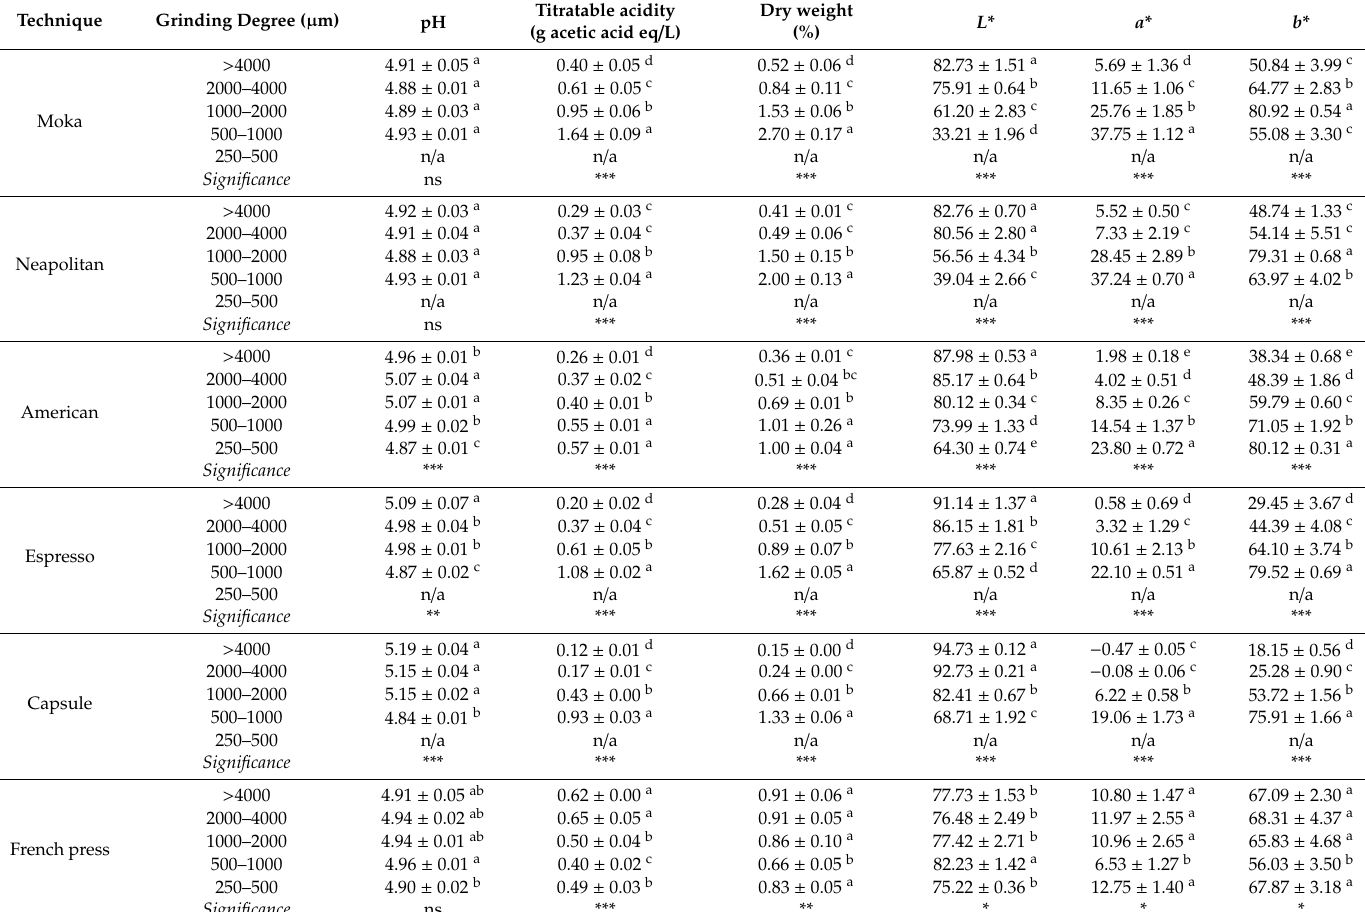
Table 2. pH, titratable acidity, dry matter, and CIELab values of the beverages obtained by each extraction technique and grinding degrees (GD) of CBS, and ANOVA among GDs for each